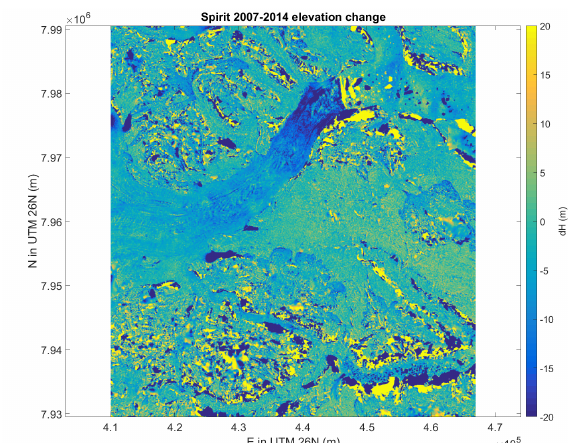
Table 2: Volume change in glacier tongue according to each dataset.